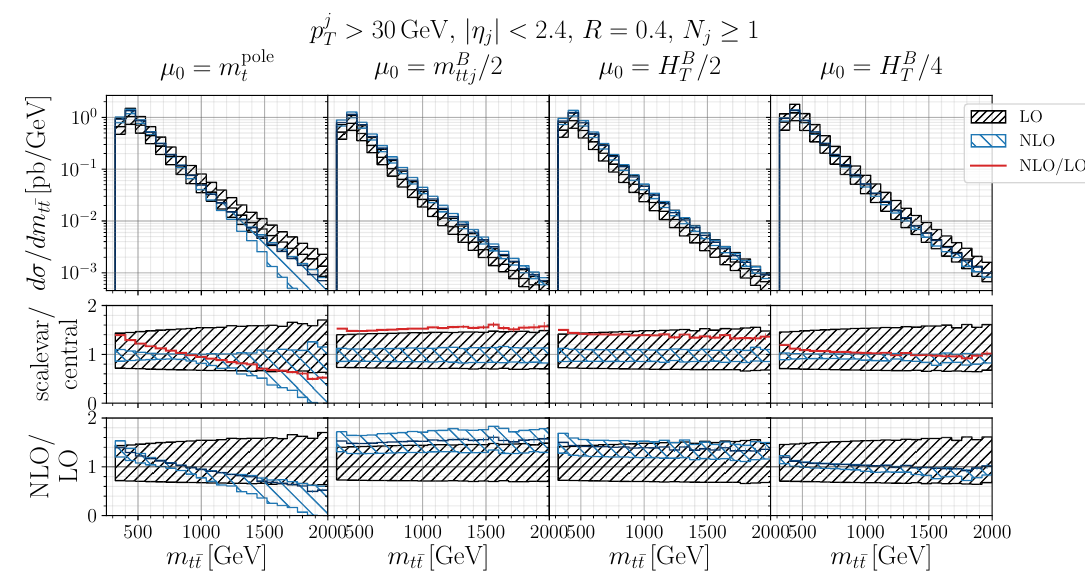
Figure 9 . Same as in figure 7, but for the m